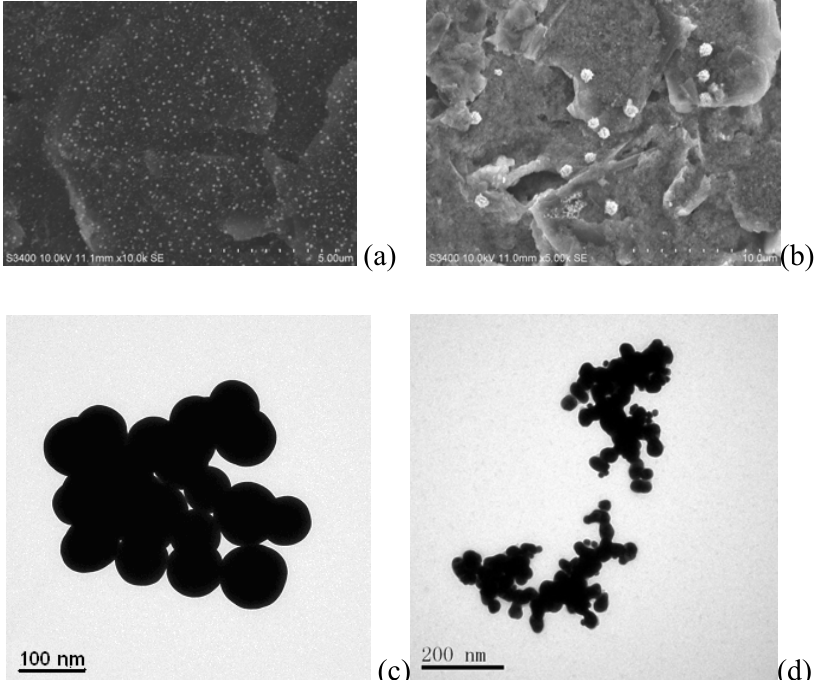
films. the TEM images of (c) pLys/GMPs, and 2